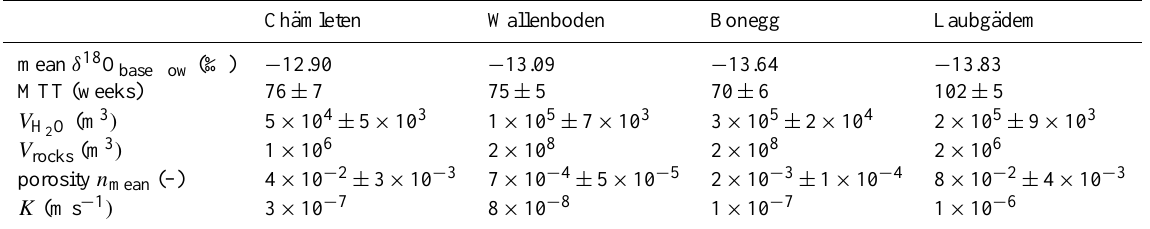
V H2O =mobile catchment storage; V rocks =volume of rocks; K =hydraulic conductivity.